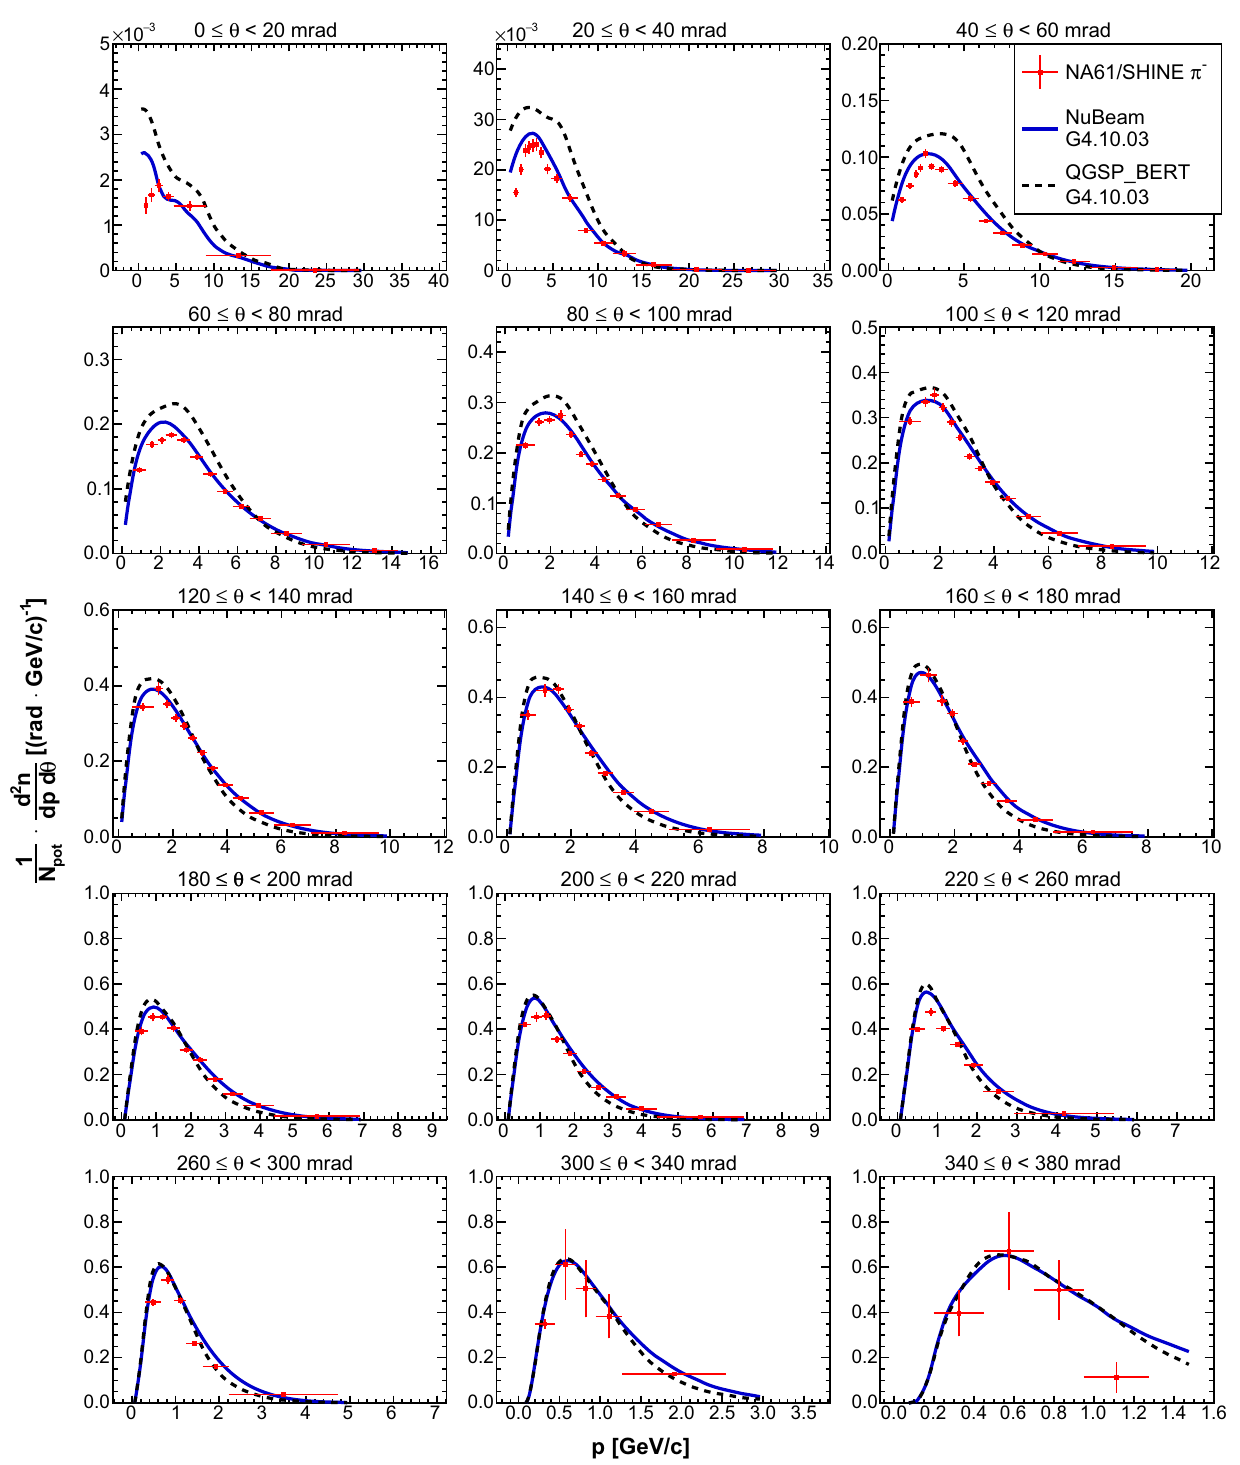
Fig. 30 Double differential yields of negatively charged pions for the second upstream longitudinal bin (18 ≤ z < 36 cm). Vertical bars represent the total uncertanties. Predictions from the NuBeam (solid